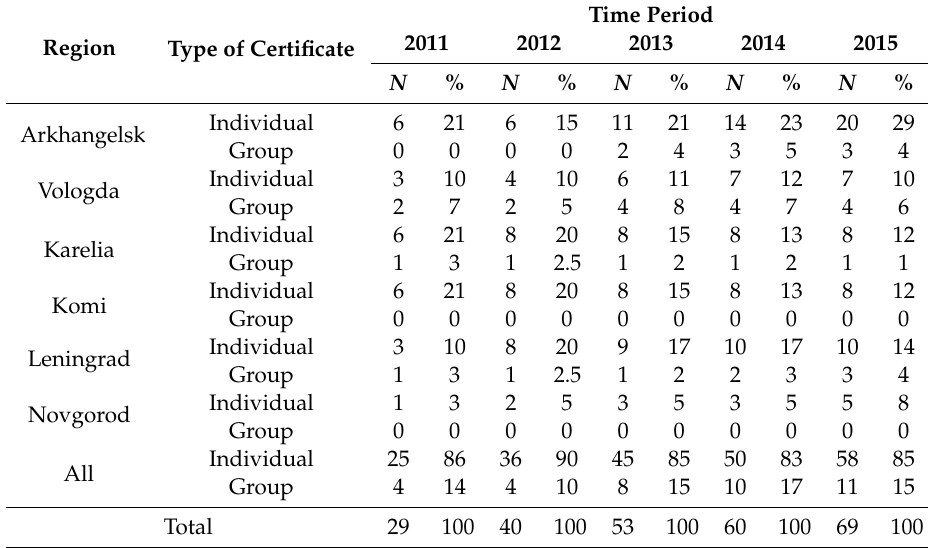
Table 2. Distribution of Forest Stewardship Council (FSC) certificates among the regions of northwestern (NW)